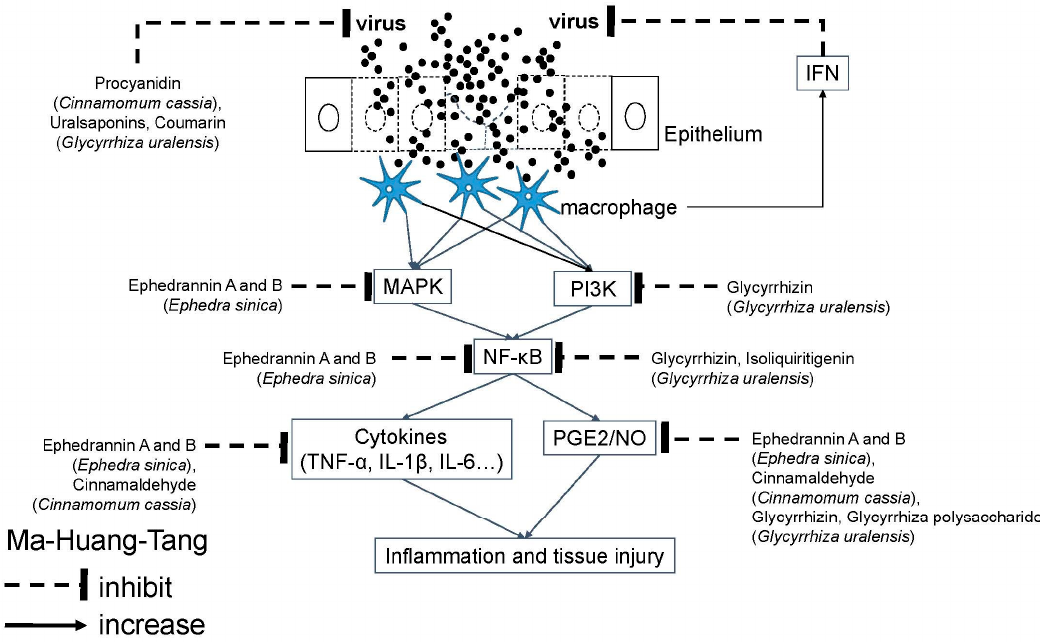
Figure 3. Molecular mechanism of Ma-Huang-Tang against airway viral infections. Airway viruses infect the epithelium to cause tissue injury. Ma-Huang-Tang contains several active molecules to inhibit viral replication and signal transduction of inflammatory response. Akt: Serine / threonine protein kinase B (PKB); COX: Cyclooxygenase; ERK: Extracellular signal-regulated kinase; IL: interleukin; iNOS: Inducible nitric oxide synthases; JNK: c-Jun N-terminal kinases; MAPK: Mitogen-activated protein kinase; NF- κ B: Nuclear factor-kappa B; NO: Nitric oxide; PG: Prostaglandin; PI3K: Phosphoinositide 3-kinase; PMN: Polymorphonuclear neutrophils; TNF: Tumor necrotic factor.